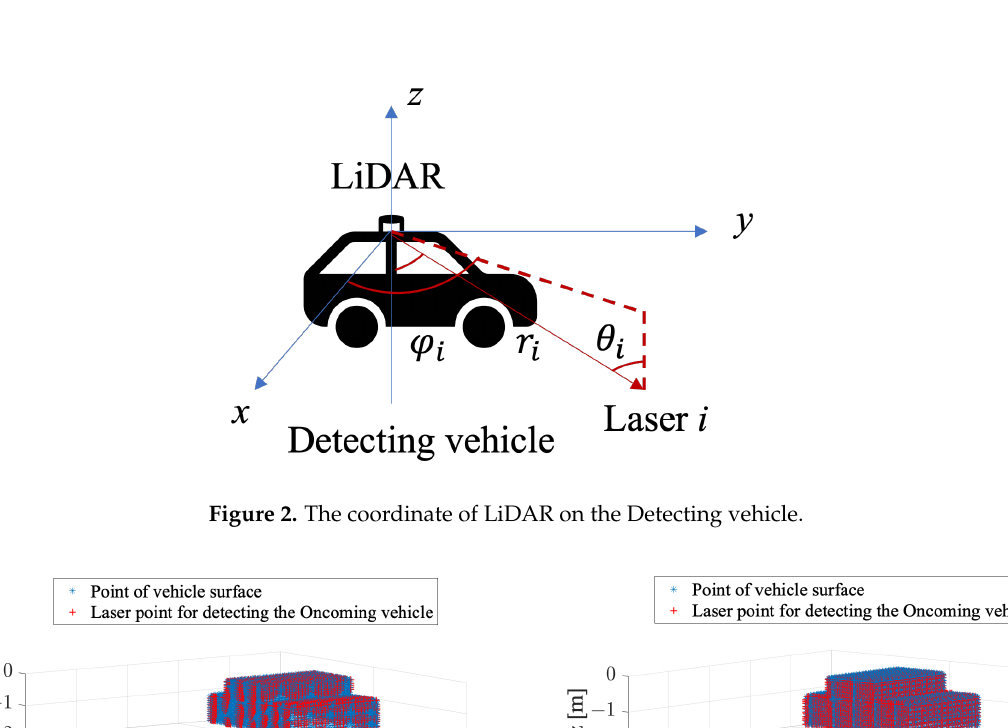
Figure 3. Model for detecting Oncoming vehicle by LiDAR on the the Detecting vehicle. ( a ) S n ( d n = 40 m ) ≥ 20 m ) ≥ 90%; ( b ) S n ( d n DO